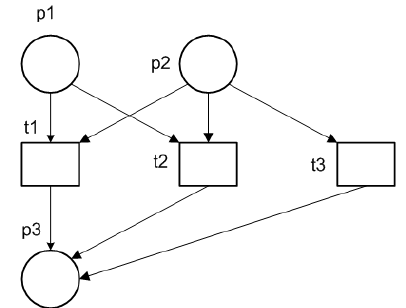
Fig. 2. A Petri net having square